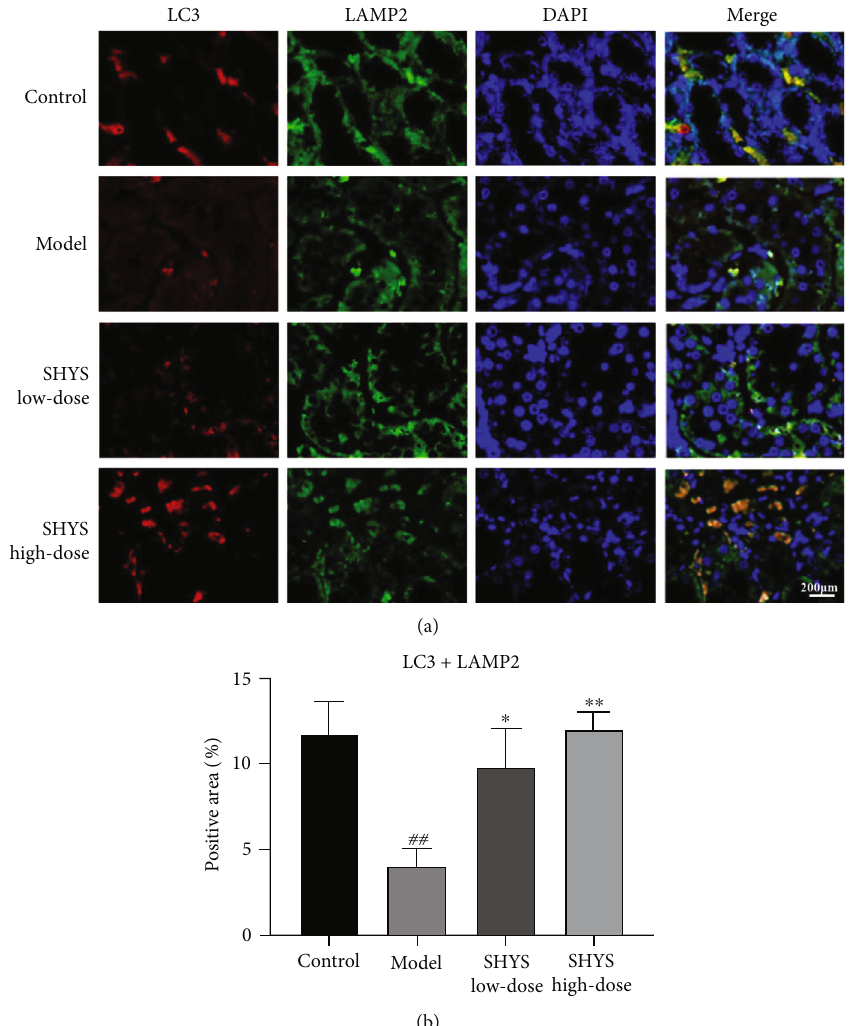
Figure 6: SHYS treatment increased the coexpression of LC3 and LAMP2 in DKD model rats. The coexpression of LC3 and LAMP2 in the kidney was investigated using immuno fl ourescence. (a) The mange of immuno fl ourescence staining in each group ( 400 × ). (b) Quantitative of immuno fl ourescence based on positive